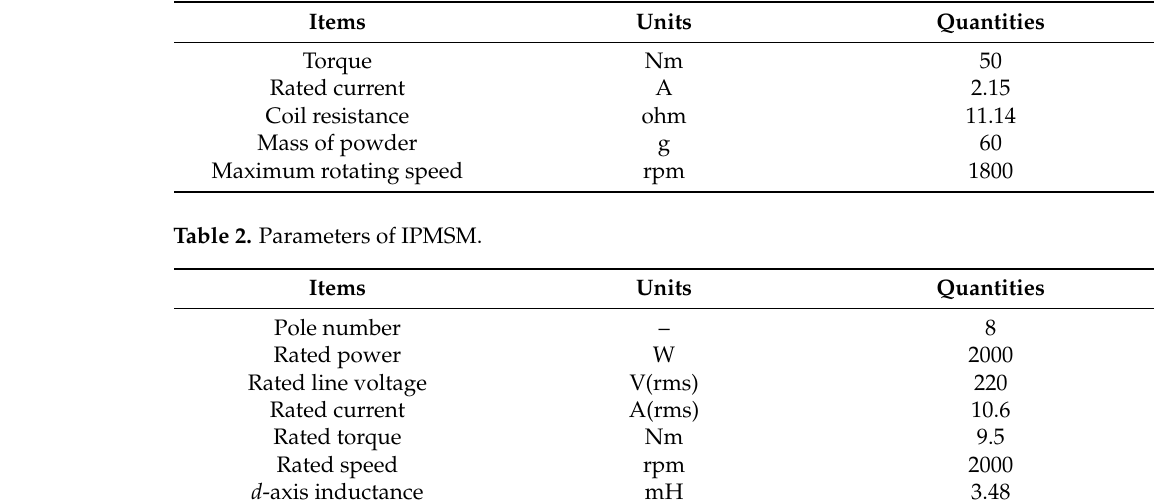
Figure 3. Photo of the experimental setup. Table 1. Parameters of magnetic powder brake.